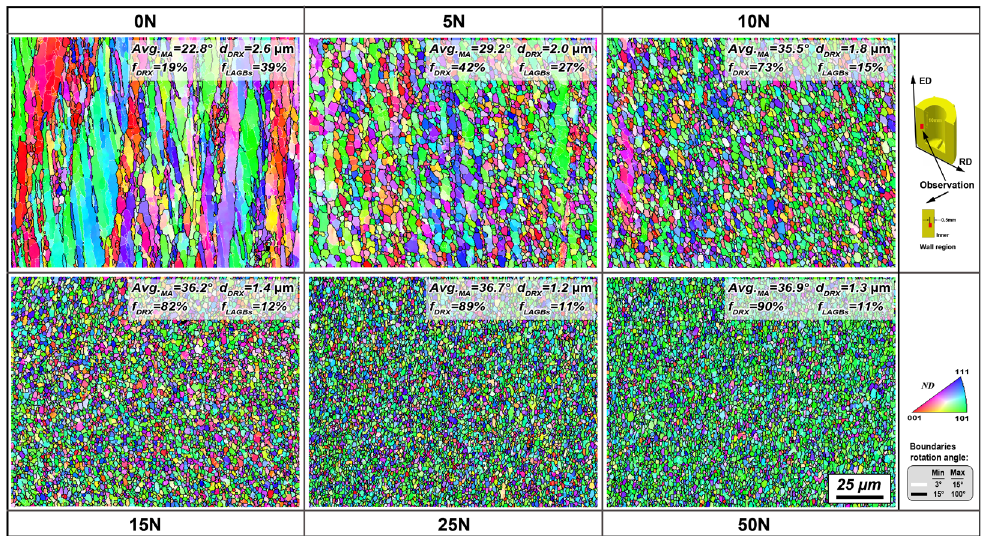
Figure 9. Inverse pole figure (IPF) coloring maps of the inner wall region of extruded samples selected from different N.